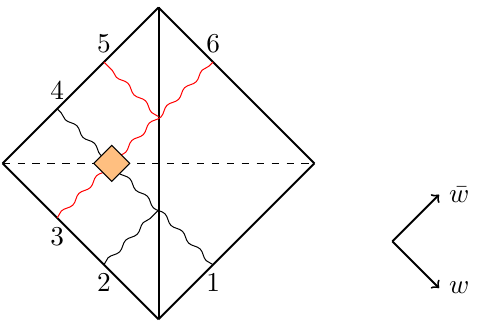
, for some (cid:12)nite D , up I